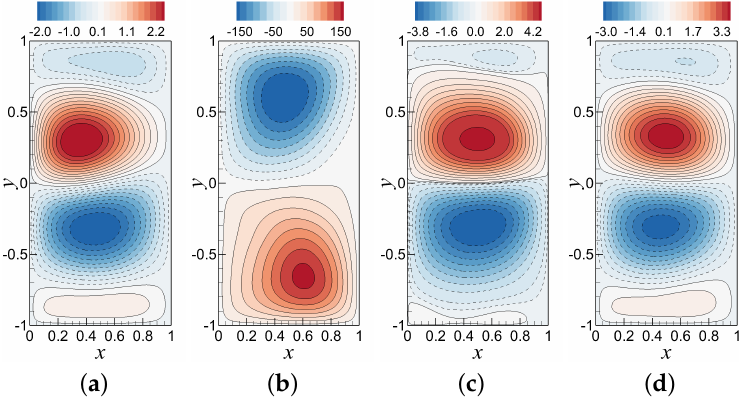
Figure 11. Mean stream function contour plots between t = 15 and t = 60 obtained by reference FOM and different ROM simulations for Re = 100 and R = 10 modes: ( a ) ψ FOM at a resolution of 128 × 256; ( b ) ψ ROM-GP ; ( c ) ψ ROM-ANN ; and ( d ) ψ ROM-H . The figure shows that ROM-ANN and ROM-H have captured the four-gyre circulation pattern similar to the FOM solution while ROM-GP has shown an unphysical two-gyre pattern.